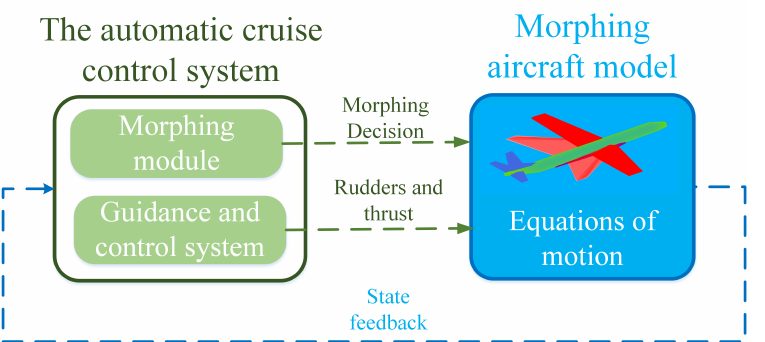
Figure 1. Closed-loop system consisting of morphing module, morphing aircraft model, and guidance and control system.